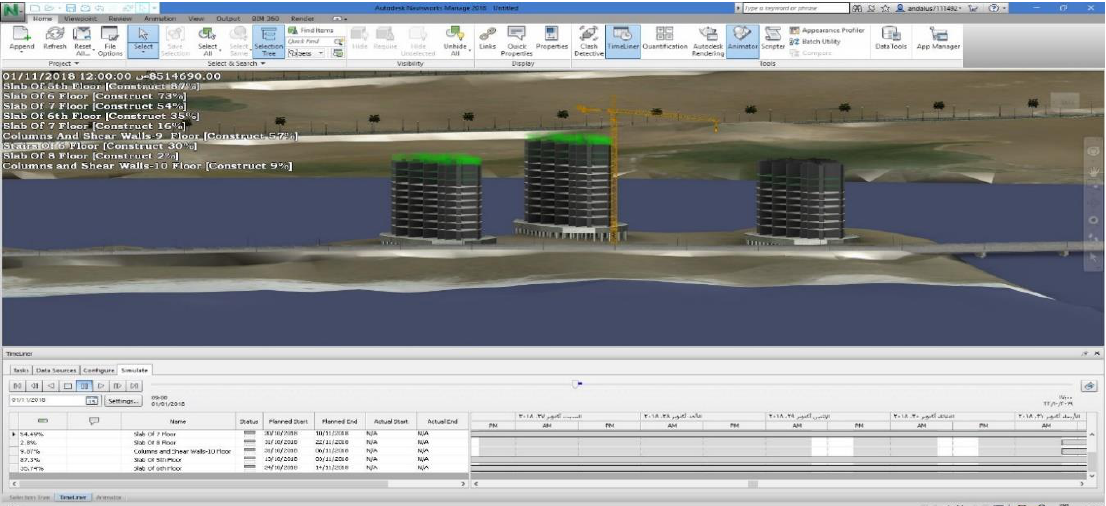
Figure 7: Navisworks (M.O.S 2 – The towers